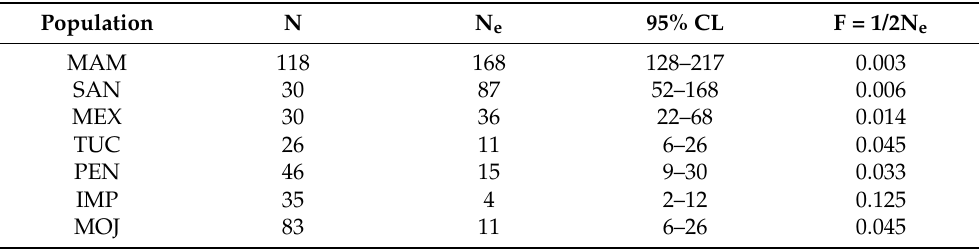
Table 2. Sample size (N), effective population size (Ne), Confidence Interval (CI) and inbreeding coefficient (F) for the seven populations of the Arapaima gigas analyzed in the present study, based on 12 microsatellite